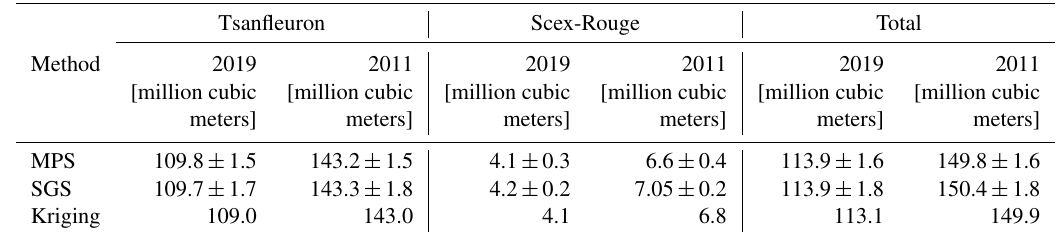
Table 3. Volumes of ice computed with the 2019 and 2011 DEMs for the Tsanfleuron and Scex Rouge glaciers.